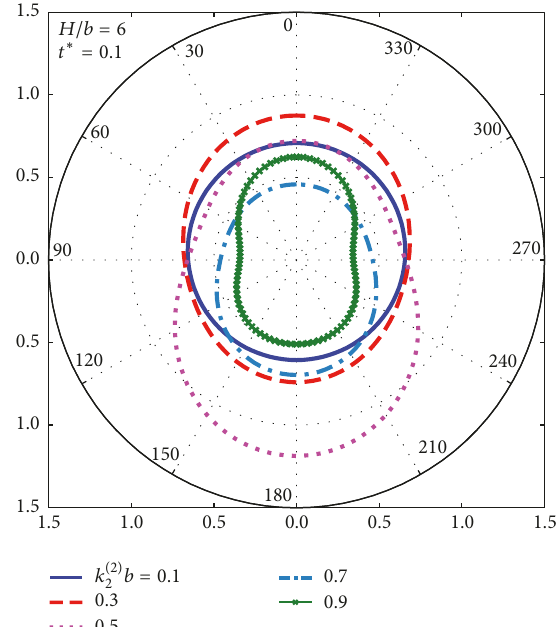
Figure 2: Radial displacement (𝑢 ∗ 𝑟 ) versus polar angle at 𝑟 = 𝑏 for different wave numbers (𝑘 (2) 2 𝑏) for a tunnel in hard soil.